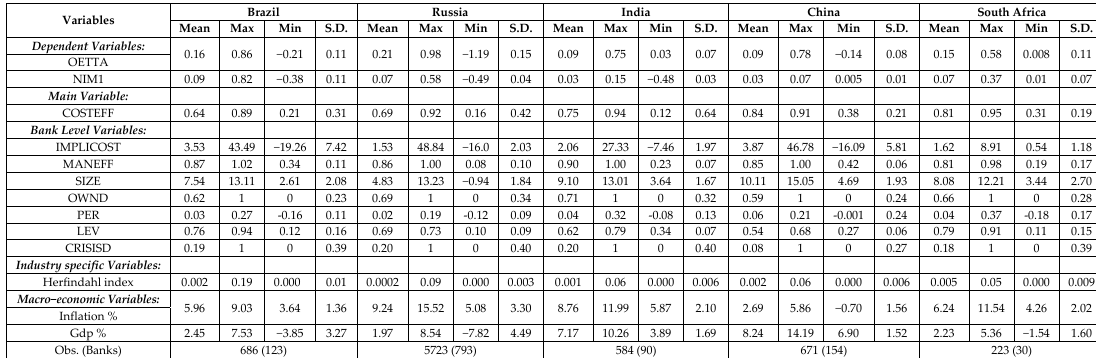
Table A2. Summary Statistics of Variables (Individual Country).